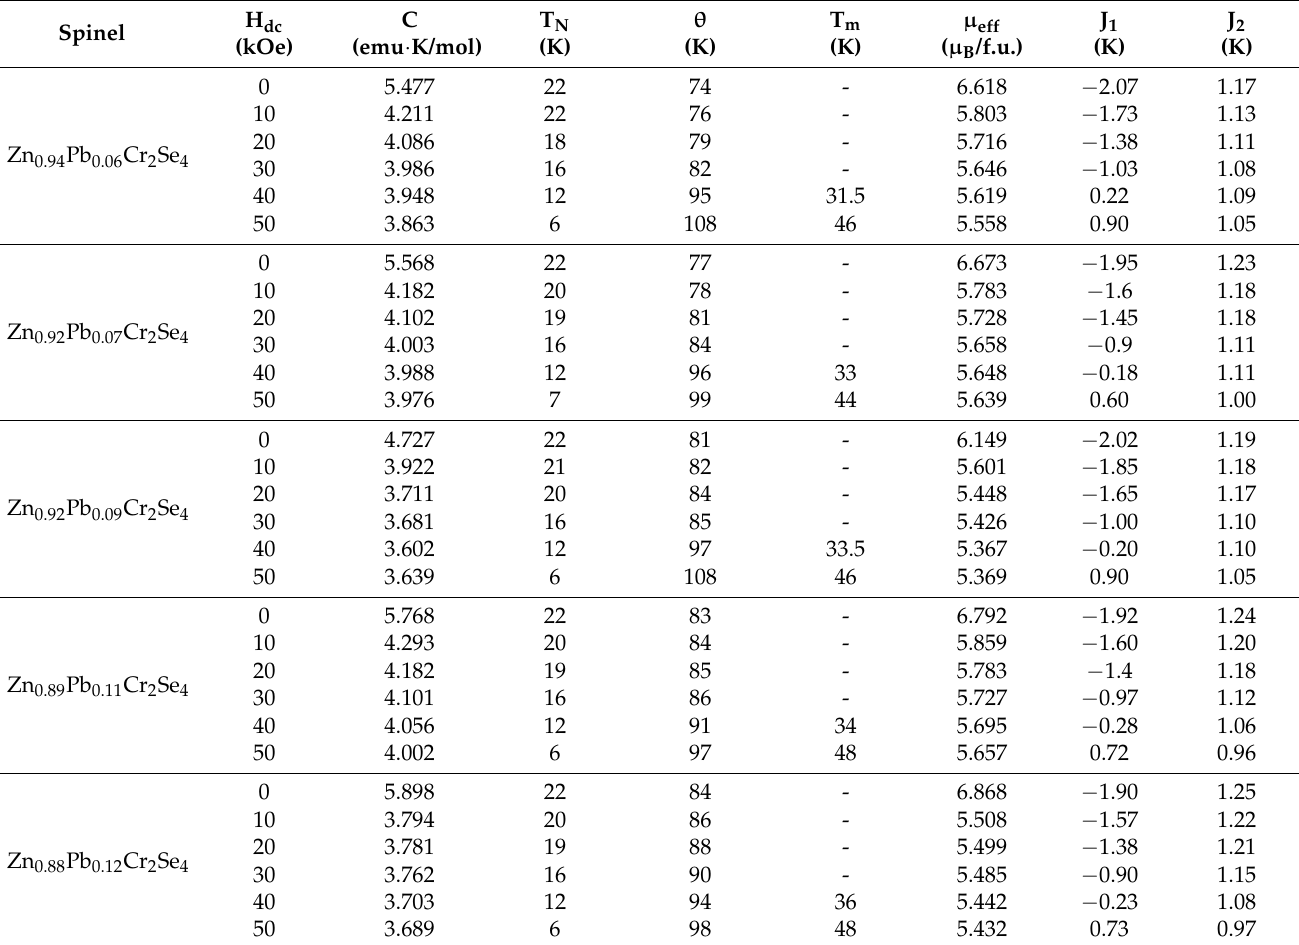
Table 6. Magnetic parameters of the Zn 1 − x Pb x Cr 2 Se 4 single crystals recorded in an internal oscillating magnetic field H ac = 1 Oe with an internal frequency f = 120 Hz and taken at external static magnetic fields H dc = 0, 10, 20, 30, 40, and 50 kOe: C is the Curie constant; T N , θ , and T m are the N é el, Curie– Weiss, and the spin fluctuation temperatures, respectively; µ eff is the effective magnetic moment; and J 1 and J 2 are the super-exchange integrals for the first two coordination